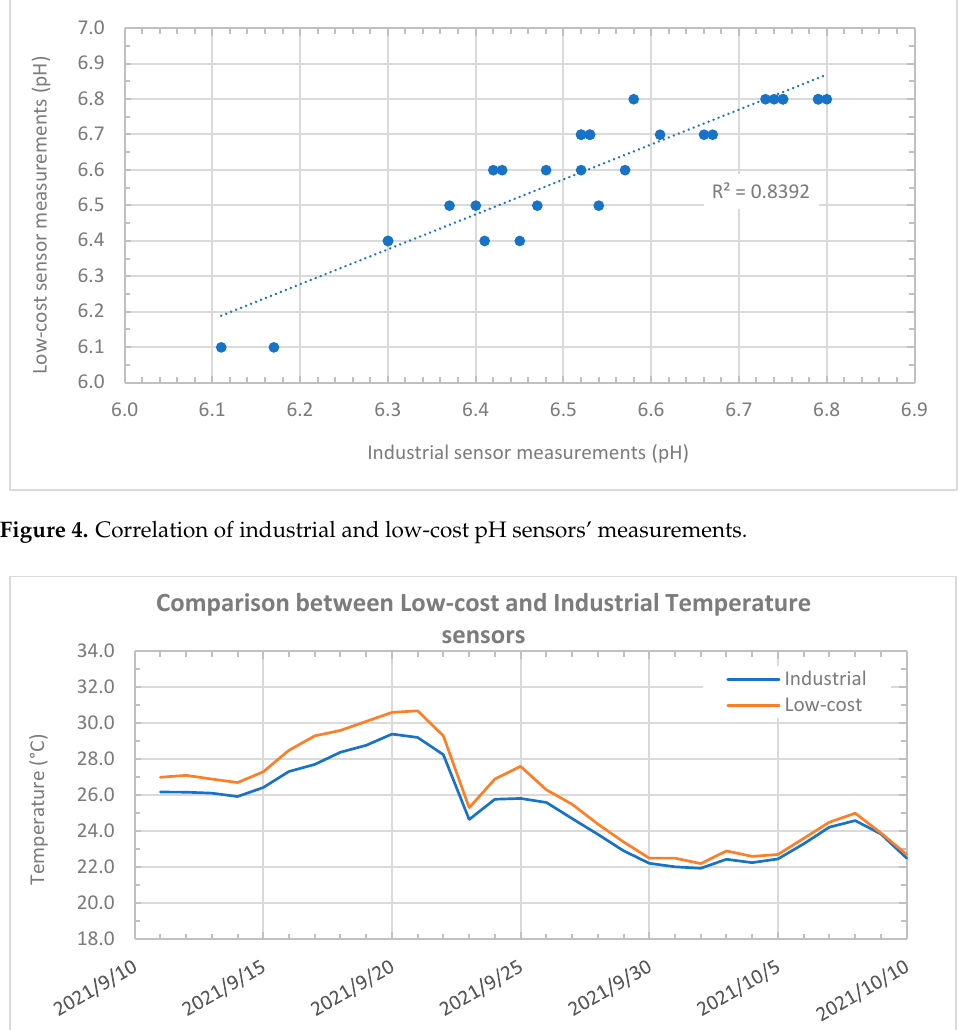
Figure 6. Correlation of industrial and low ‐ cost temperature sensors’ measurements.